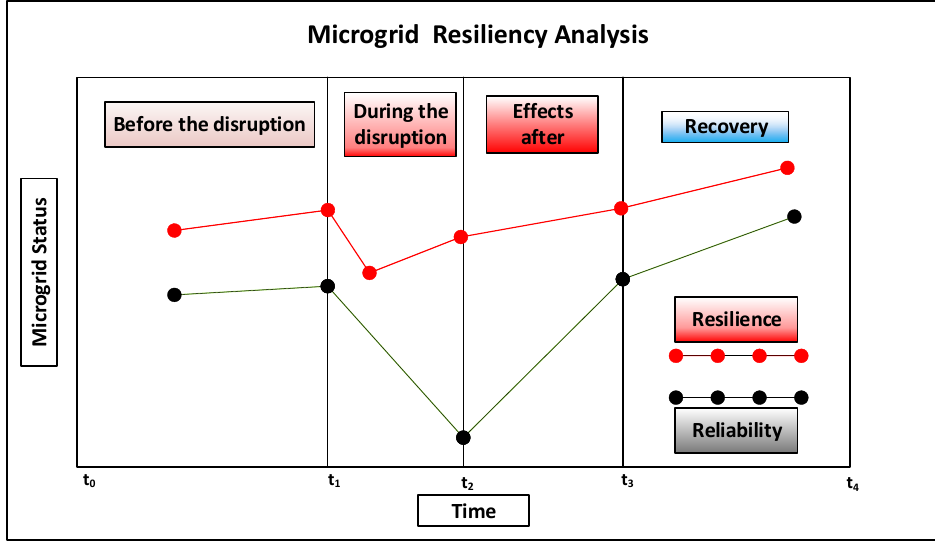
Figure 8. Microgrid Status vs. Time Comparison (Resilience vs. Reliability Comparison).